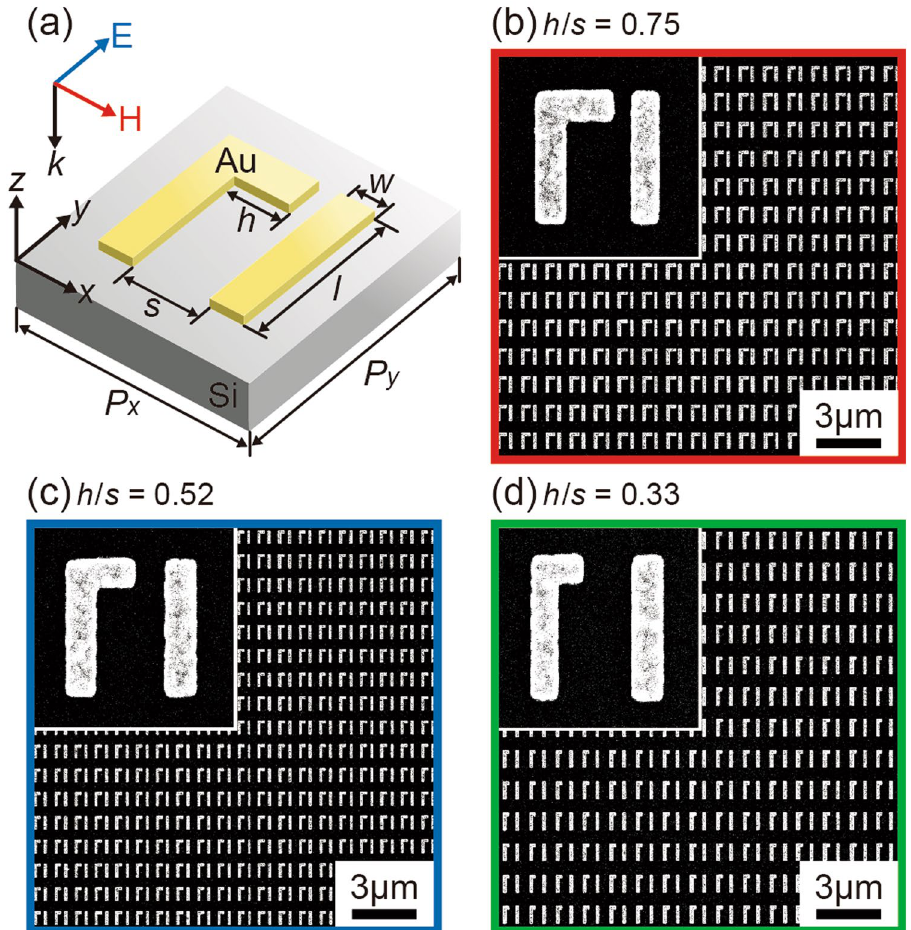
Figure 1. Design and fabrication of metamaterials. ( a ) Schematic unit cell of a metamaterial on a Si substrate consisting of an Au nano-rod pair with a horizontal coupling antenna to break the structural symmetry. The surface structure was designed to exhibit the pronounced Fano resonance at 1730 cm − 1 , which spectrally overlapped with the C = O vibrational mode. ( b – d ) SEM images of the fabricated metamaterials with different antenna lengths of h / s = 0.75 (red), 0.52 (blue), and 0.33 (green) to tune the excitation of the Fano resonance. To match the Fano-resonant frequencies of all the metamaterials even with different antenna lengths, other geometry parameters were carefully designed (see the Methods